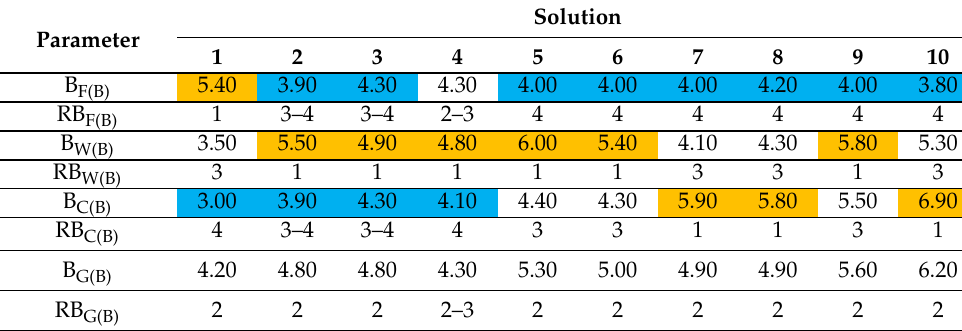
Table 5. Survey results and ranking of mean brightness perception levels of computer image of corridor for each solution, in group